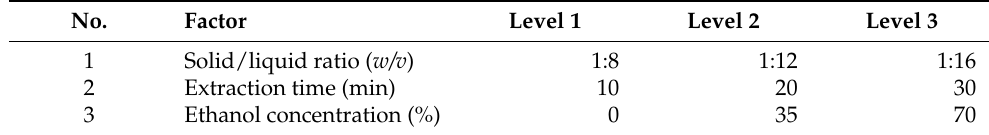
Table 7. Factors considered for the optimization of extraction conditions. No. Factor Level 1 Level 2 Level